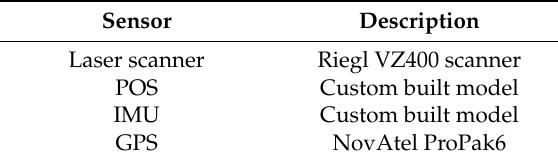
Figure 7. Rotor-wing large-UAV power inspection robot. Table 1. LiDAR specifications.